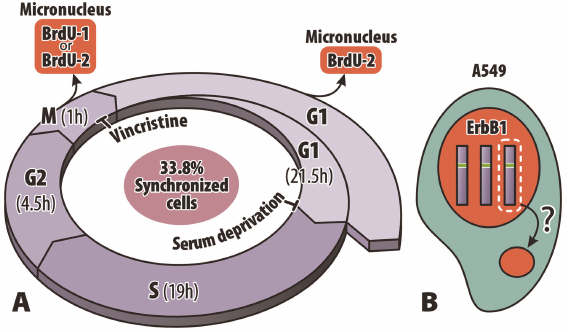
Figure 6. Summary of the main results of this study. A , Schedule of cell cycle synchronization showing the time of each cell cycle phase and the double blockade with serum deprivation and vincristine made to analyze the origin of micronuclei according to BrdU-1 and BrdU-2 assays. B , One aim of this study was to evaluate the possible extrusion of ErbB1 extra copies by micronucleus formation. The data suggested that there was no selective extrusion of the amplified gene. BrdU: 5-bromo-2-